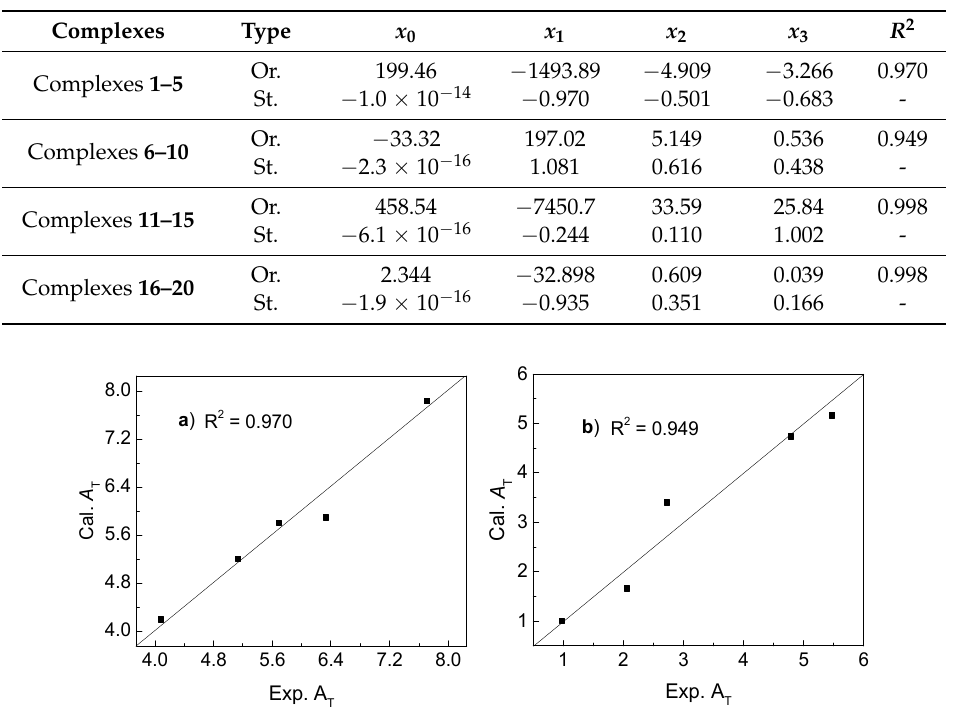
Table 3. The original and standardized regression coefficients ( x ) values of multiple linear regression equation as well as correlation coefficients ( R 2 ) for the complexes. Or., original; St., standardized . Complexes Type x 0 x 1